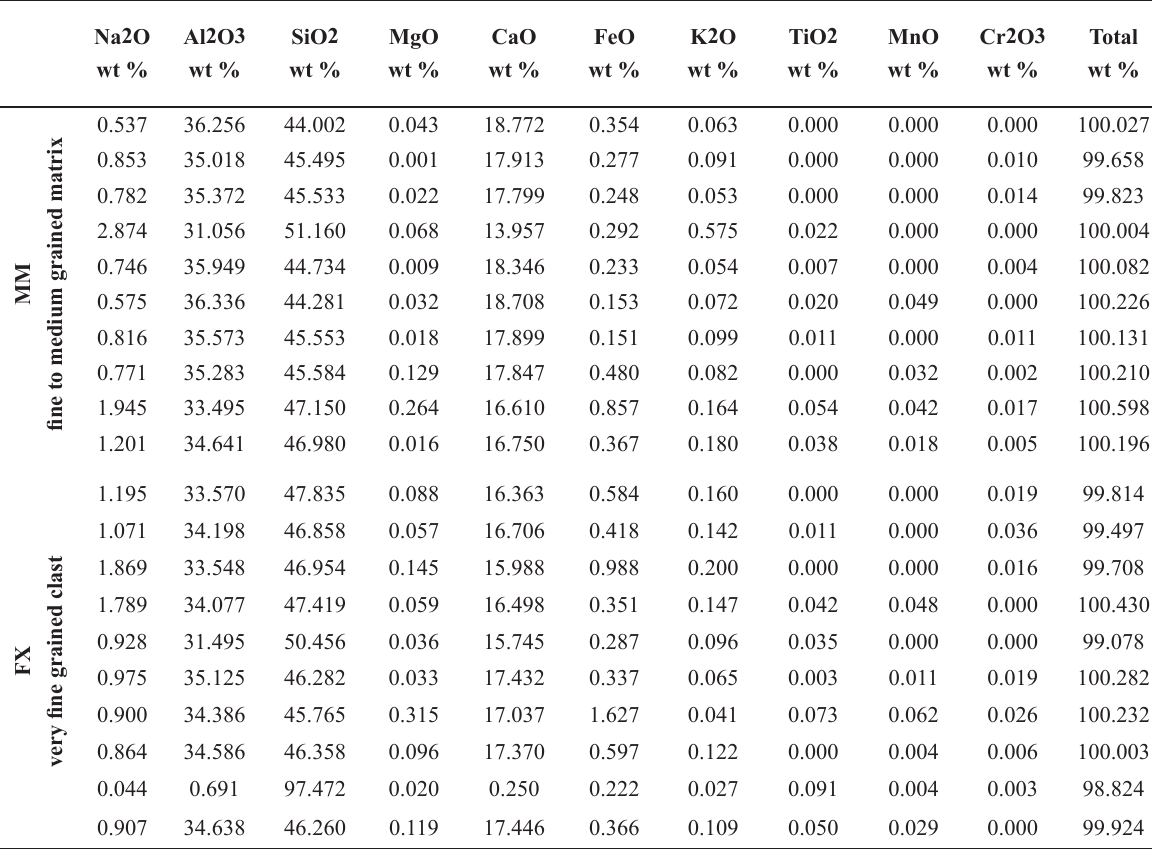
Major and trace element composition of plagioclase from the different lithologies present in Serra Pelada meteorite. Quantitative WDS analysis in wt.